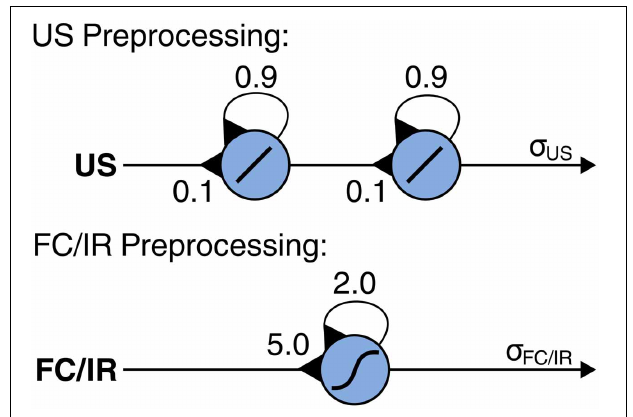
FIGURE 3 | Recurrent neural modules for signal preprocessing of ultrasonic (US), foot contact (FC), and infrared (IR) sensors. US preprocessing applies two recurrent neurons using a linear transfer function where the incoming connection weights are set to 0 . 1 while the recurrent weight of each neuron is set to 0 . 9. FC and IR preprocessing modules both apply a single recurrent neuron using a hyperbolic transfer function where the incoming connection weights are set to 5 . 0 and the recurrent weights are set to 2 . 0. The neural parameters of all sensory preprocessing modules were chosen